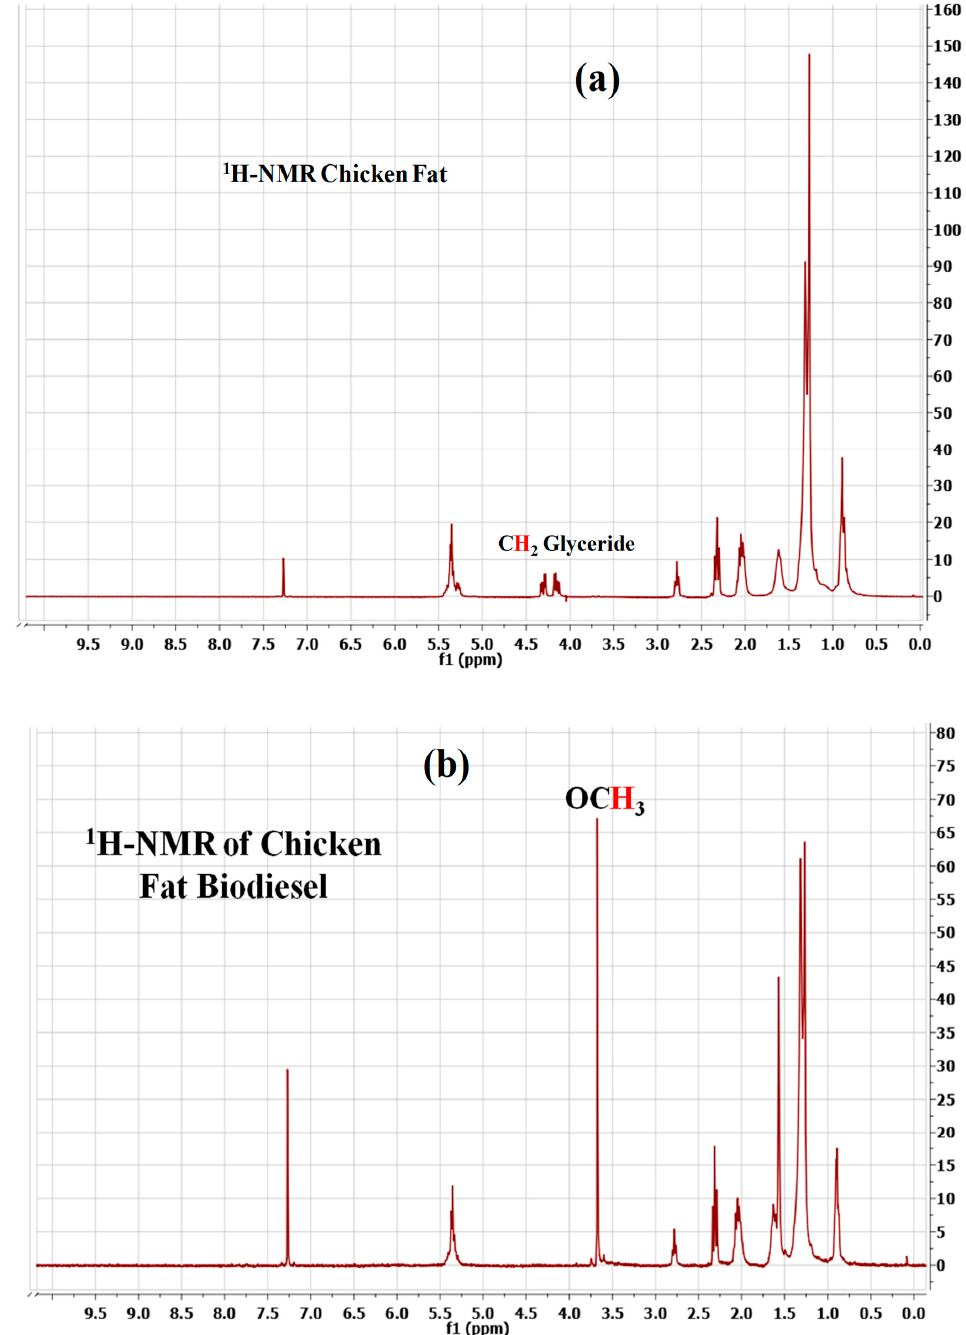
Figure 13. 1 H NMR spectra of: ( a ) CF, and ( b ) CF-derived